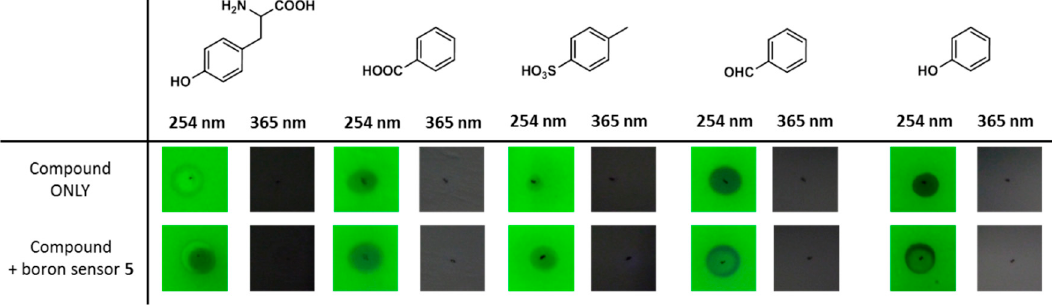
Figure 6. Staining test of boron-free compounds spotted onto silica-gel plates followed by the addition of boron sensor 5 (viewed by illumination at 254 or 365 nm using a handheld UV lamp).